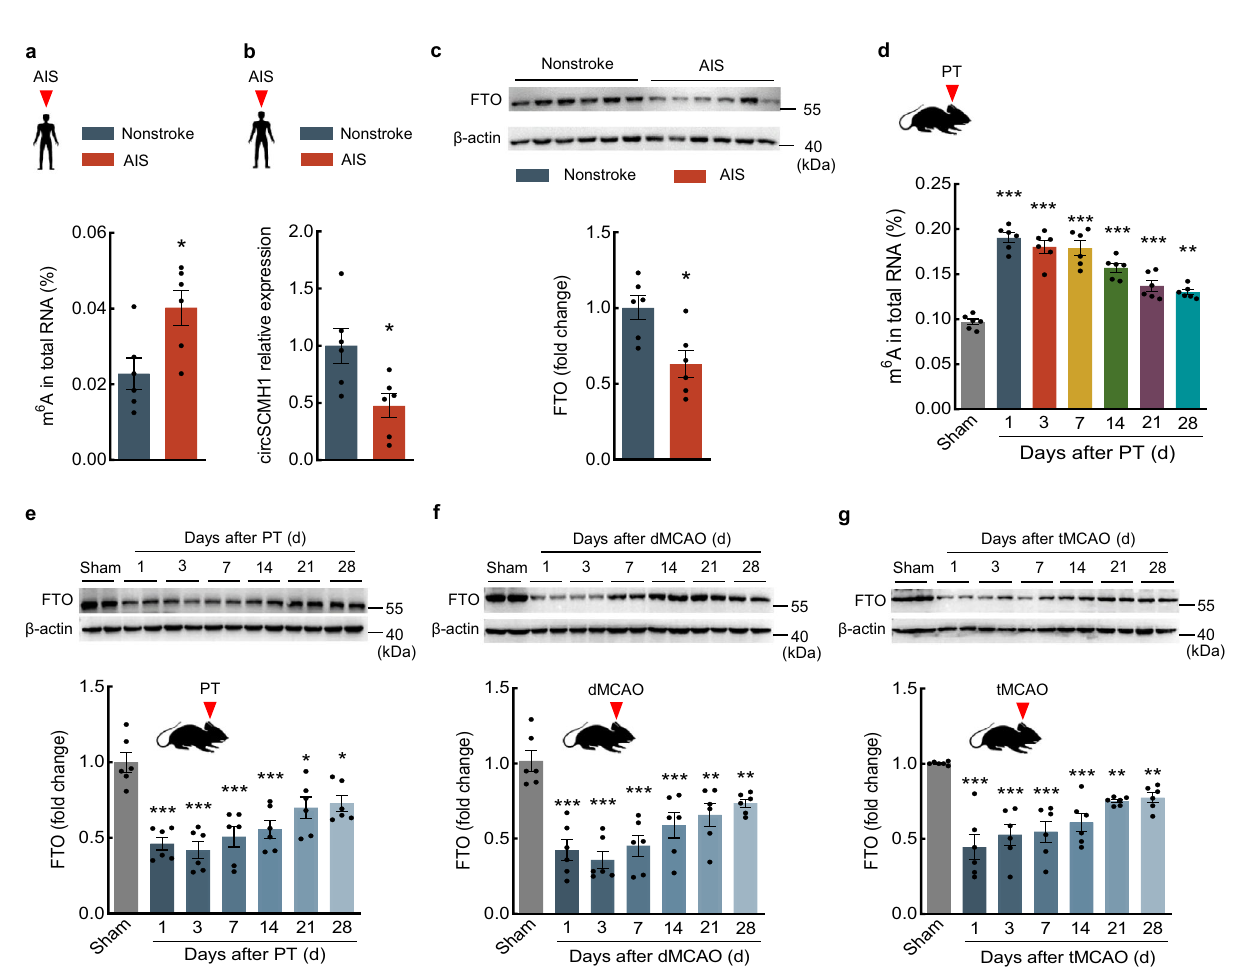
Fig. 1 | CircSCMH1 promoted vascular repair during stroke recovery. a Schematic of EV-circSCMH1 administration and staining analysis in monkeys. b , c Representative images with CD31 staining showing blood vessels in the peri- infarct cortex at day 28 after PT in monkeys, followed by the analysis of vascular area fraction, total vascular length, and the number of branches. Scale bars, 100 μ m. n =4 monkeys/group. * P =0.0337, ** P =0.0018, *** P =0.0004 versus PT+ EV-Vector. d Schematic of EV-circSCMH1 administration and staining analysis in mice. e , f Representative images with CD31 staining showing blood vessels in the peri-infarct cortex at day 28 after PT in mice, followed by the analysis of vascular areafraction,totalvascularlength,andthenumberofbranches.Scalebars,100 μ m (overview), 20 μ m (insets). n =6 mice/group. *** P =0.0008 (vascular area), *** P =0.0004 (vascular length, numbers of branches) versus sham; # P =0.0253 (vascular area), ## P =0.0041 (vascular length), ## P =0.0043 (numbers of branches) versus PT+EV-Vector. g Representative images and quanti fi cation of newly gen- erated BrdU + /CD31 + endothelial cells in the peri-infarct cortex at day 28 after PT. Scale bars, 20 μ m. n =6 mice/group. ** P =0.0018 versus sham; ### P <0.0001 versus PT+EV-Vector. h Representative images and quanti fi cation of CD13 + pericyte